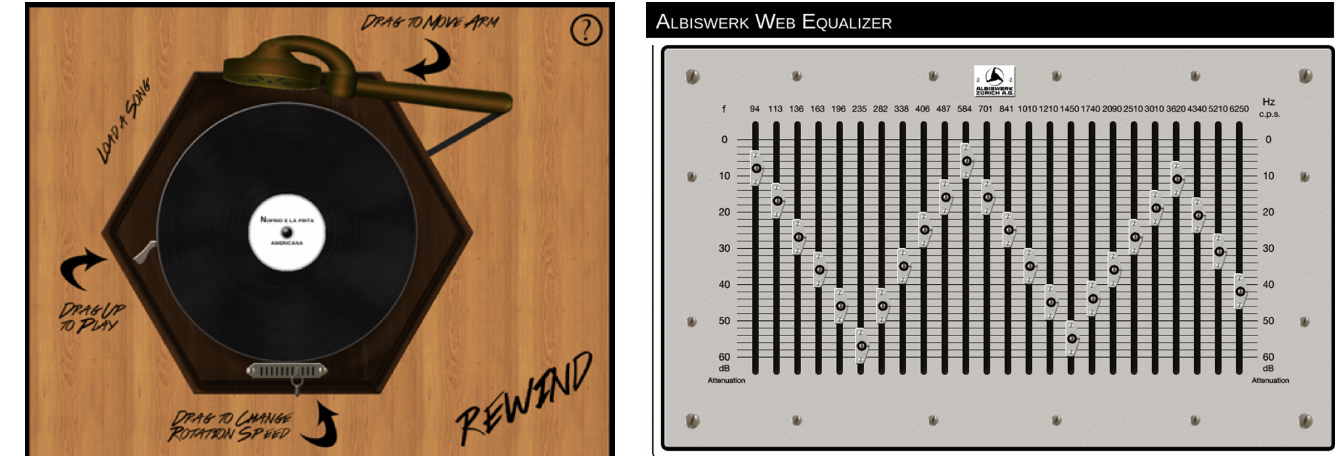
Figure 14. Virtualization of an old gramophone ( left ). Virtualization of Albiswerk model 502/50 equalizer ( right ): a library of the historical equalization curves used in electroacoustic music and shellac phonographic discs is